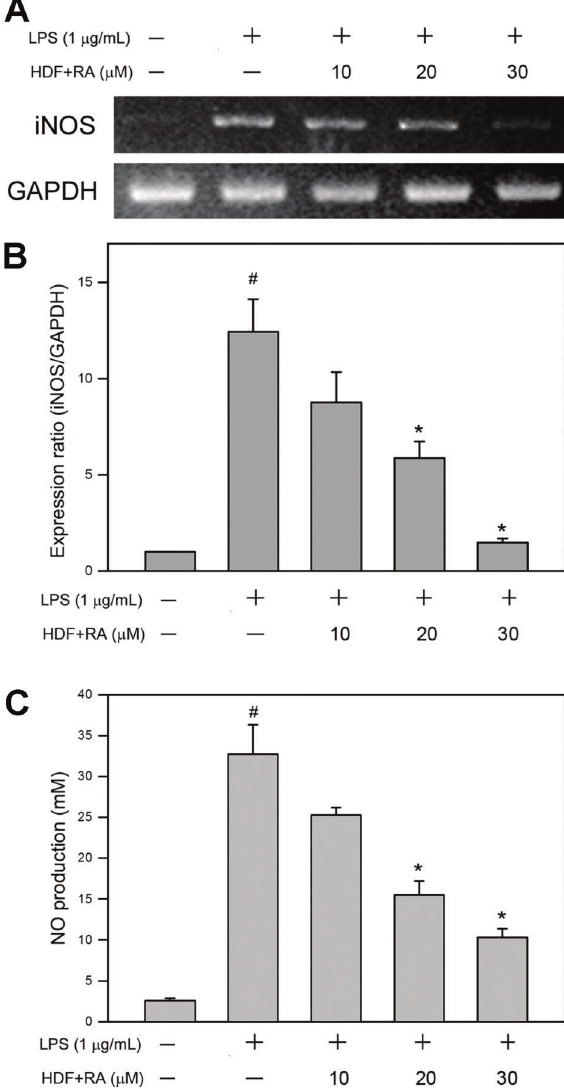
Figure 3. Hemodialysis fl uid (HDF) supplemented with rosmarinic acid (RA) suppressed mRNA expression of inducible nitric oxide synthase (iNOS) and nitric oxide (NO) production by lipopoly- saccharides (LPS)-stimulated human umbilical vein endothelial cells. Detection and quantitation of iNOS were done by RT-PCR ( A ), and q-PCR ( B ). The culture medium after the treatment was collected for NO assay. The concentration of NO was determined by Griess reagent using NaNO 2 as standard ( C ). Data are reported as means ± SD. Three independent experiments were performed for quantitative and statistical analysis. # P o 0.05 compared to control; *P o 0.05 compared to LPS alone